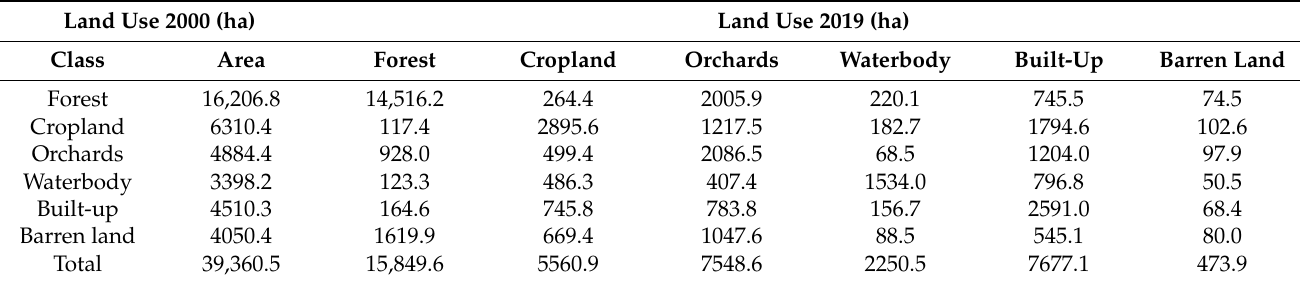
Table 8. The transformation matrices for changes of LULC classes from 2000 to